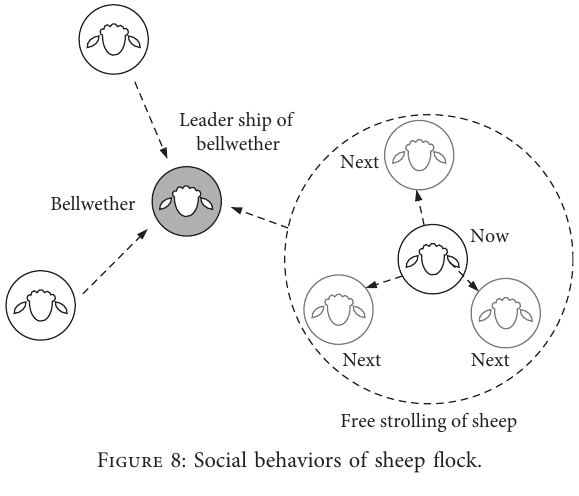
Figure 8: Social behaviors of sheep flock.